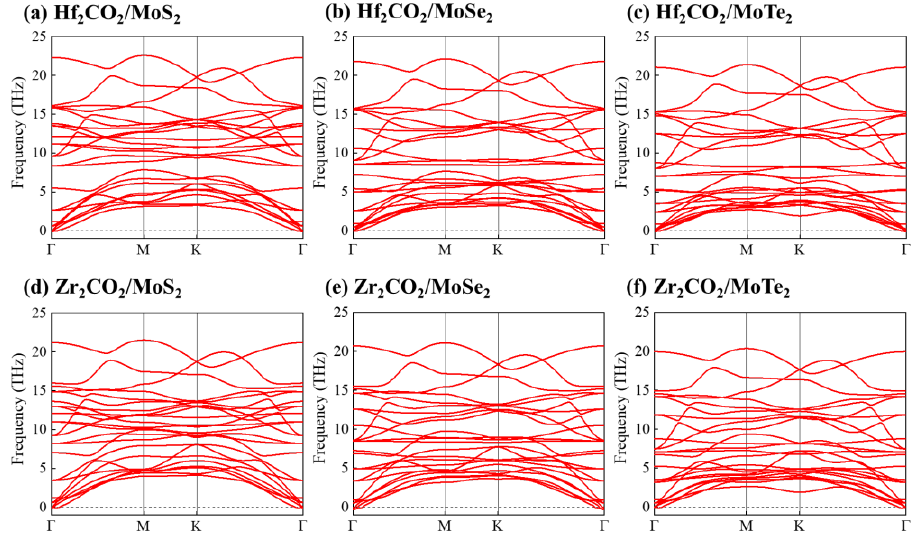
Figure 2. The phonon dispersion curves of ( a ) Hf 2 CO 2 /MoS 2 , ( b ) Hf 2 CO 2 /MoSe 2 , ( c ) Hf 2 CO 2 /MoTe 2 , ( d ) Zr 2 CO 2 /MoS 2 , ( e ) Zr 2 CO 2 /MoSe 2 , and ( f ) Zr 2 CO 2 /MoTe 2 heterostructures.